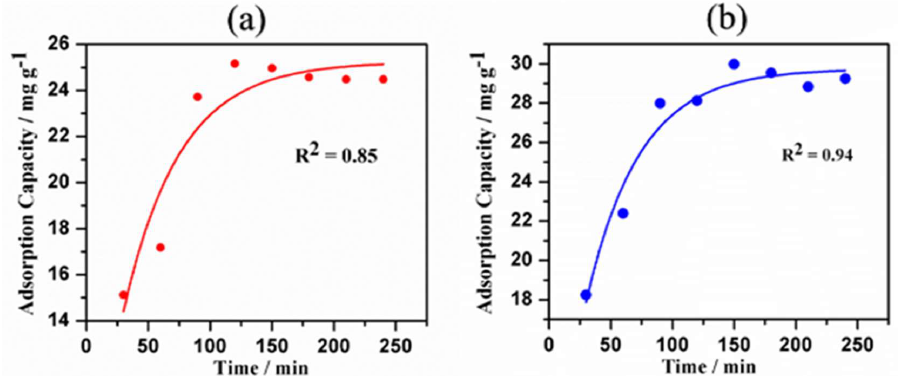
Figure 10. A plot of adsorption capacity of ( a ) Ni 2+ and ( b ) Cd 2+ ions adsorbed onto hematite nanoparticles over time.